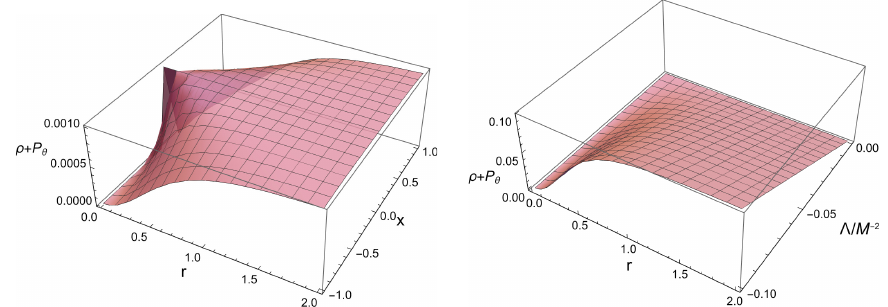
Figure 2. Plots of ρ + P θ = ρ + P φ with r for different values of x = cos θ and Λ / M − 2 = − 0.001 ( left ) and for different values of Λ / M − 2 and θ = π /4 ( right ). The value of spin parameter in the above plots is a / M =